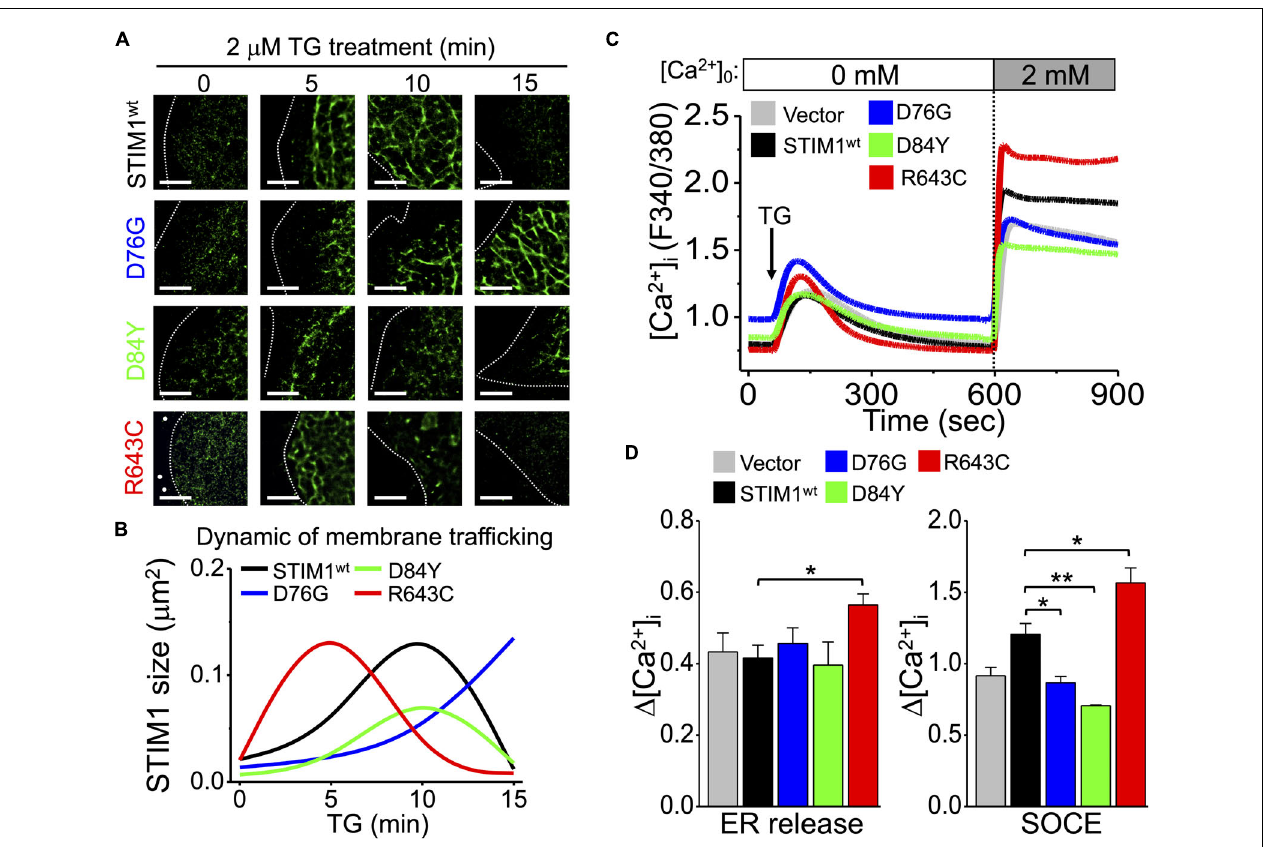
FIGURE 7 | Mutations of STIM1 cEF hand and S/TxIP motifs affect the aggregation and trafficking of STIM1. (A) Representative dSTORM images showing the intracellular distributions of SiHa cells with different STIM1 variants in TG-induced SOCE. Dashed line, cell periphery. White dots, TetraSpeck microspheres. Scale bar, 5 µ m. (B) Quantitative analyses of SiHa cells with different STIM1 variants based on the intracellular area and size of STIM1 in TG-induced SOCE. Data from at least 30 ROIs from more than three different cells. (C) Mean traces of [Ca 2 + ] i measured from three independent experiments with different STIM1 variants. Arrow, adding 2 µ M TG. (D) (Left) Quantitative analyses of changes in ER Ca 2 + levels ( (cid:49) [Ca 2 + ] i ) and (Right) quantitative analyses of changes in SOCE Ca 2 + levels ( (cid:49) [Ca 2 + ] i ) in SiHa cells with different STIM1 variants. Column, mean ± SEM from three independent experiments, each independent experiment concluding at least 30 cells. * P < 0.05, ** P < 0.01, compared with wild-type group by one-way ANOVA with a Dunnett’s post hoc